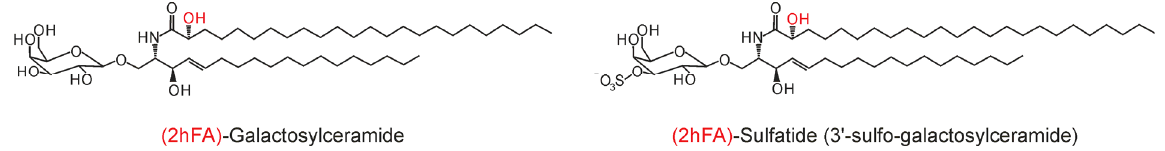
Figure 5. Structure of galactosylceramides and sulfatides (3’-sulfo-galactosylceramide). Both sphin- golipids are present as non-hydroxylated and 2-hydroxylated (> 50% in mammals) variants in the myelin of the brain and PNS in most (though not all) vertebrates.